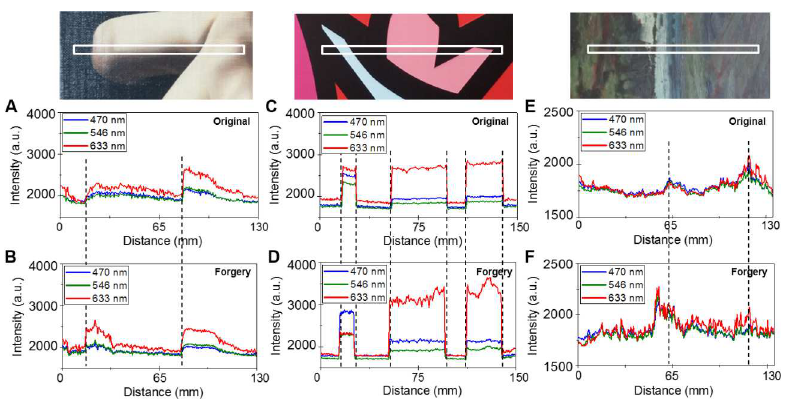
Fig 3. The RGB data from the genuine works and the forgeries. The RGB spectral data from the white boxes in (A) the genuine Self-portrait and (B) the forged Self-portrait ,(C) the genuine Morpheme and (D) the forged Morpheme , and (E) the genuine Unknown and (F) the forged Unknown